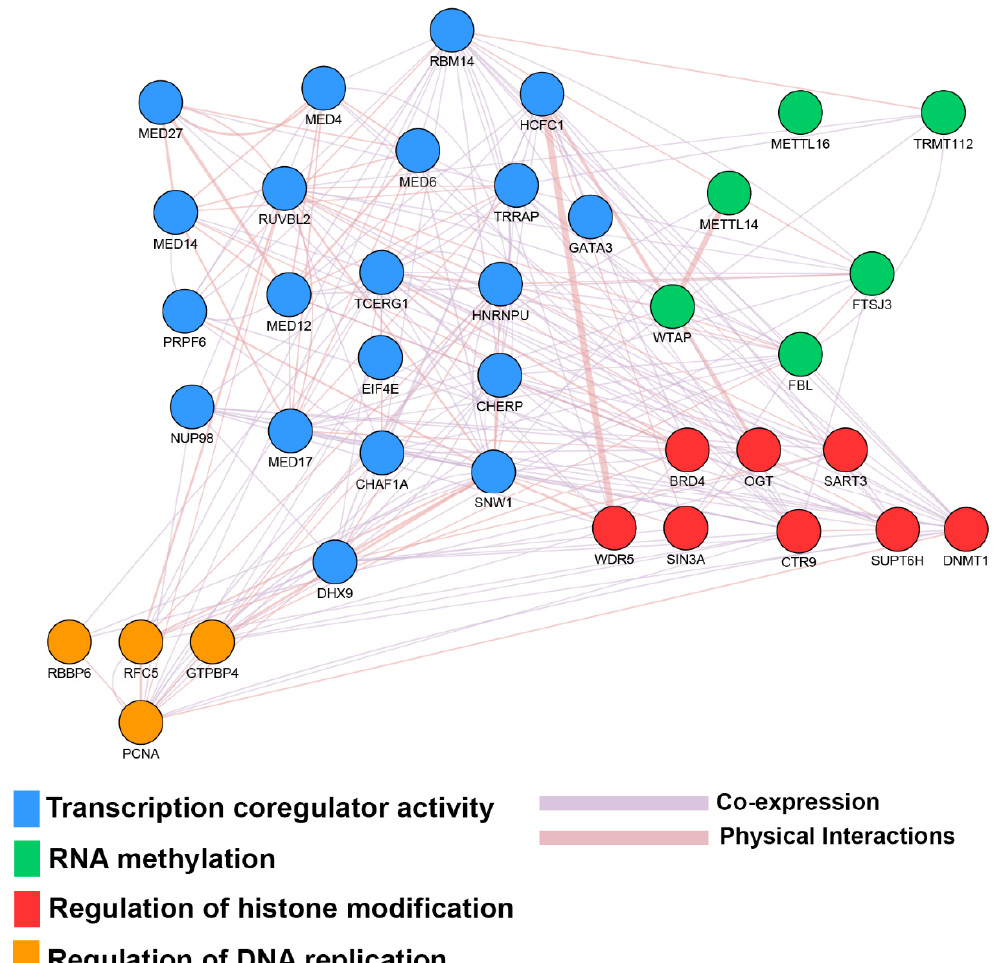
Figure 3. Biological functions involving essential genes in ER + BC encoding ER α interactors. Network showing the top statistically significant biological functions involving essential genes found in common with ER α interactors. The edges represent physical interactions and coexpression among the proteins. Their width is proportional to the strength of interactions.